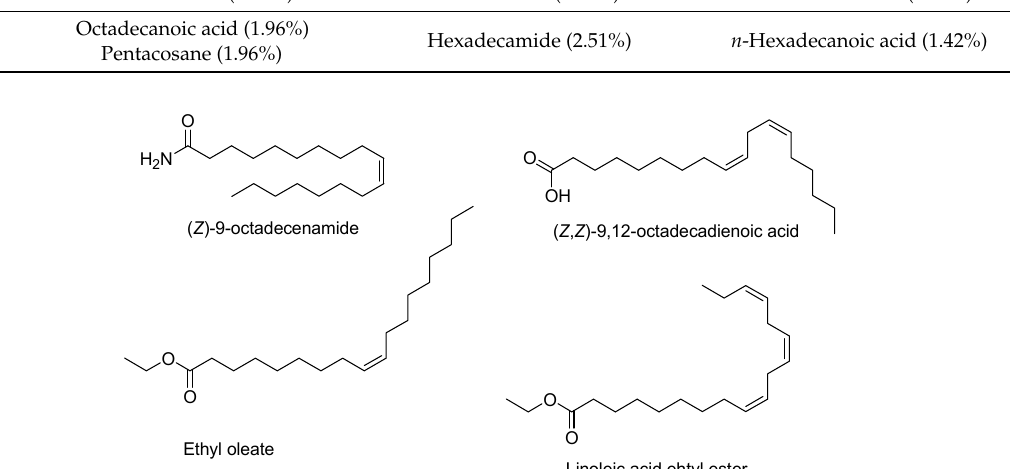
Figure 3. The chemical structures of the most intense components in “golden ring”, “pumpkin pie” and “snow chrysanthemum”.